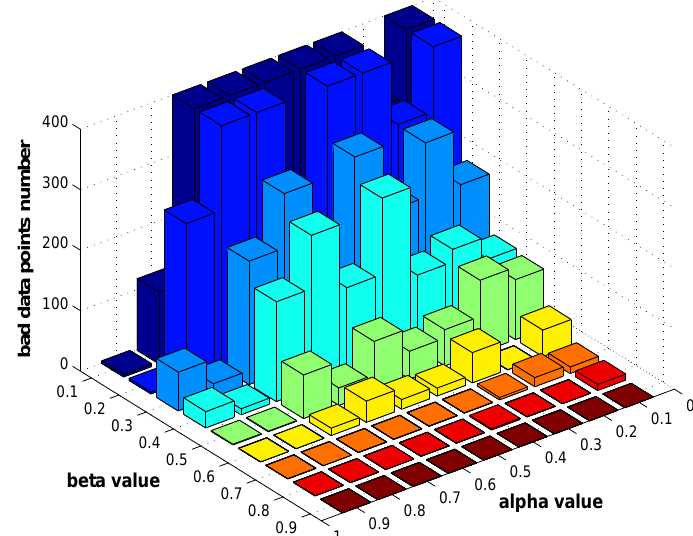
Figure 13. The influence of α and β on the “bad data points” identification, m = 5.